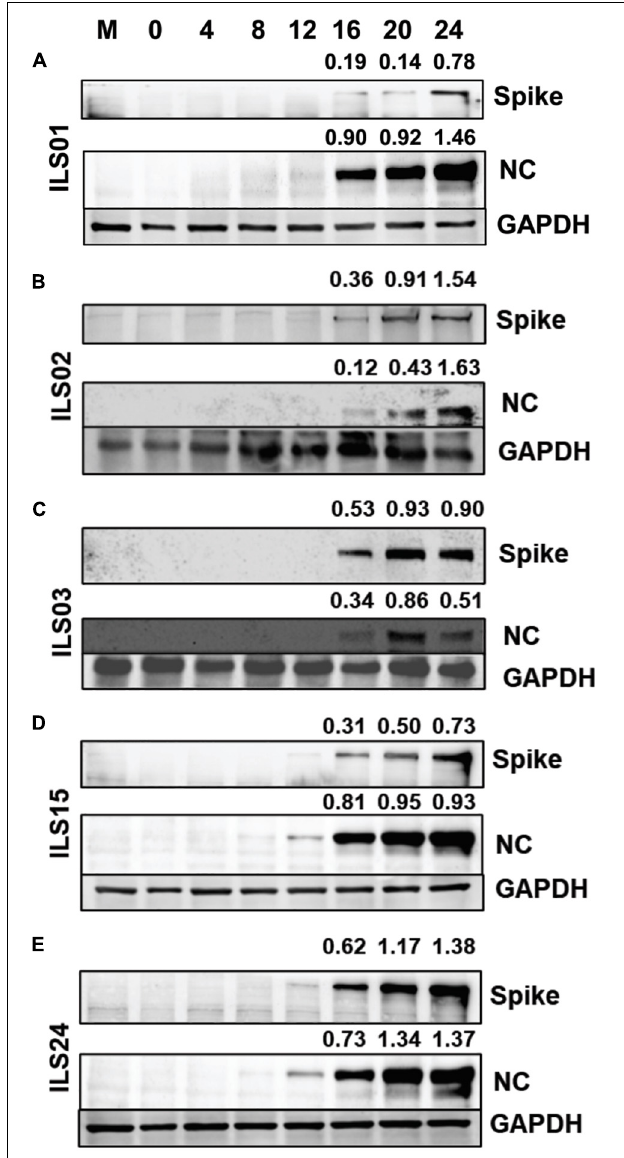
FIGURE 2 | Time kinetics of viral gene(s) expression. Vero E6 cells infected with respective isolates of SARS-CoV-2 were collected at indicated time points post-infection. Cell lysates were subjected to Western blot analysis with antibodies against SARS-CoV-2 spike and nucleocapsid proteins for each isolates individually (A–E) . GAPDH was used as an internal loading control. Quantification was done by densitometry using ImageJ software and the number represented the fold of each (spike or nucleocapsid) value normalized to the value of